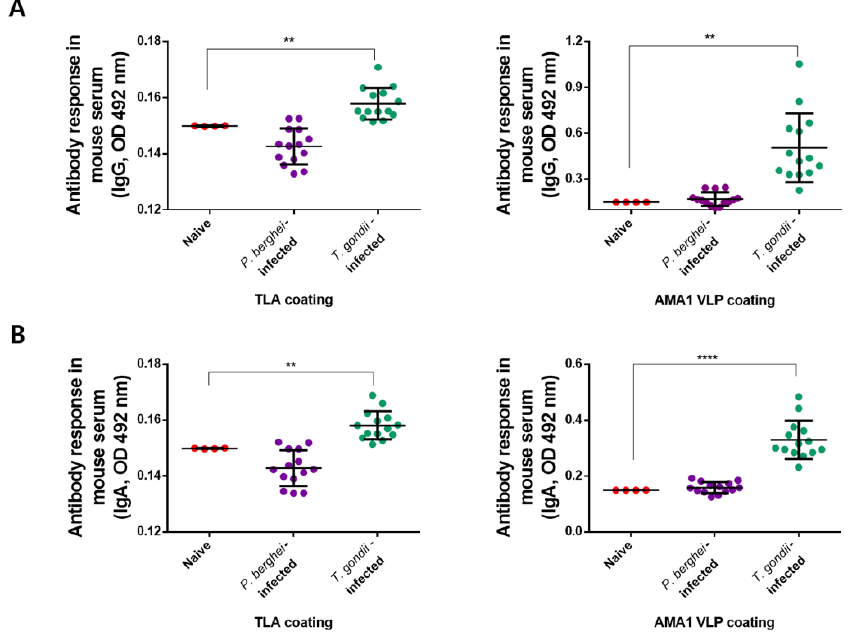
Figure 6. Parasite-specificity of mouse IgG and IgM antibody responses against AMA1 VLPs antigen. To confirm whether the elicited antibody responses against TLA and AMA1 VLPs are highly specific for T. gondii but not other Apicomplexan parasites, mice infected with the rodent malaria pathogen P. berghei and sera were collected. IgG ( A ) and IgA ( B ) antibody responses against both TLA and AMA1 VLPs were compared using the P. berghei or T. gondii immune sera via ELISA. Data are presented as mean ± SD and are representative of the three individual experiments performed in triplicate (** p < 0.01, **** p < 0.0001 vs. Naive).